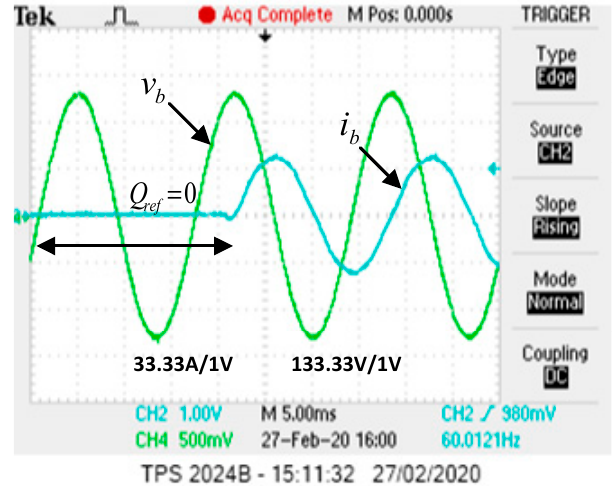
Figure 14. Voltage and current for phase B during Qref = 0 to Qref = 10 kVAr and Pref = 0.